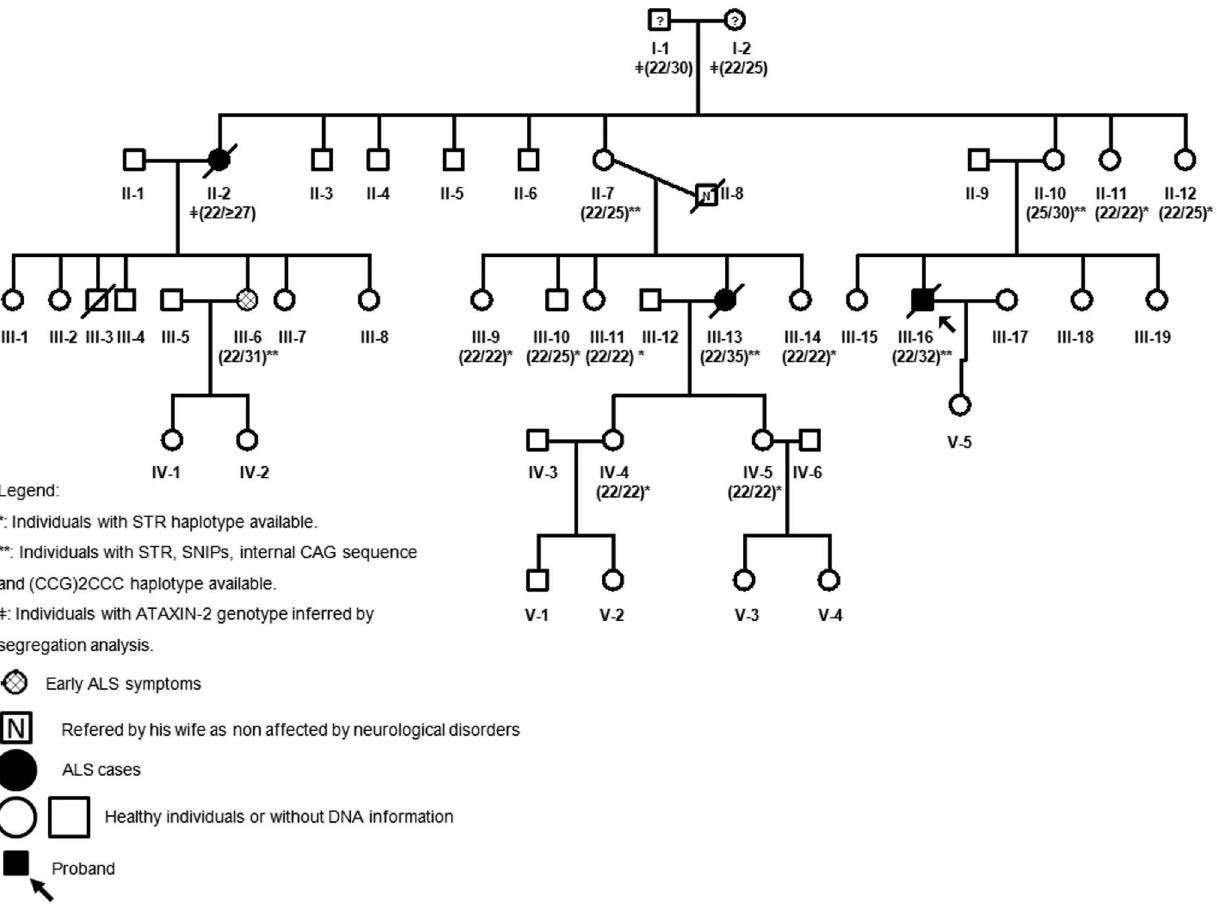
Figure 1. Pedigree of family in which novel sequence variants and three denovo mutations were identified.